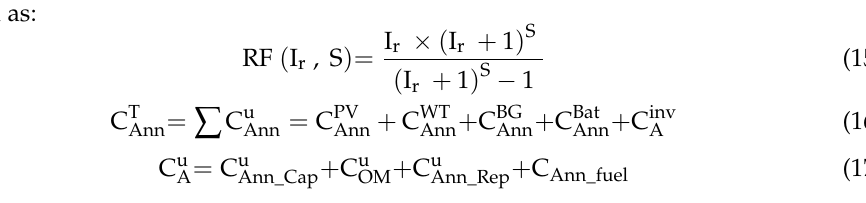
Figure 6. The biomass consumption of the studied area.